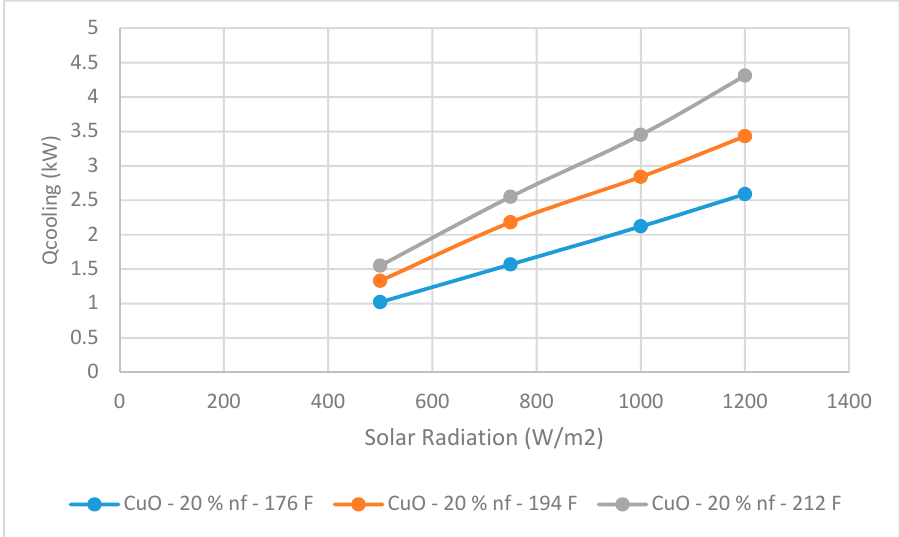
ff ect produced with CuO at di ff erent Figure 13. Cooling load effect produced with CuO at different temperatures. Figure 13. Cooling load e Figure 13. Cooling load effect produced with CuO at different temperatures.